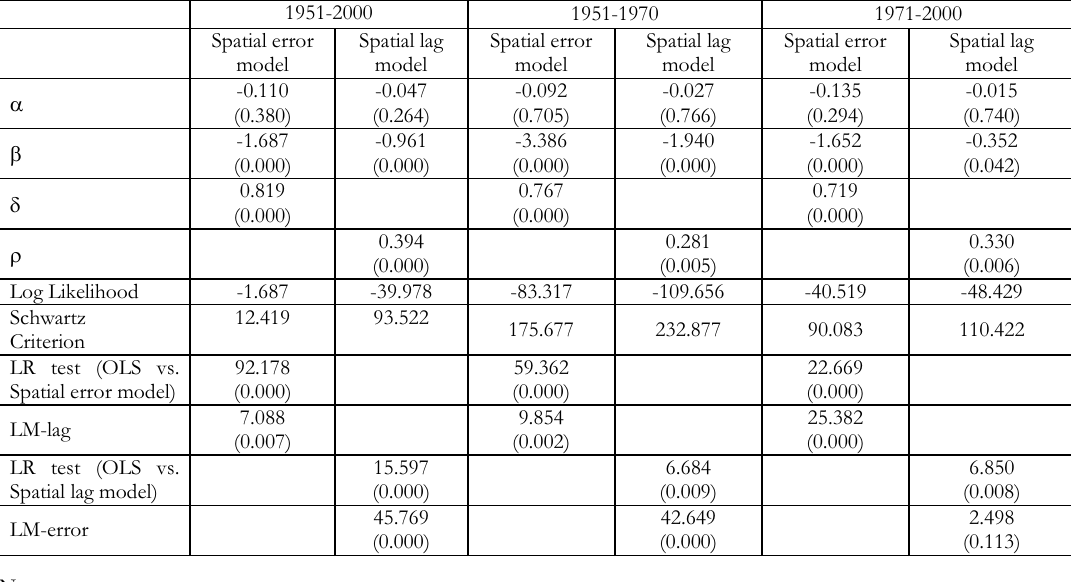
Per Capita Income Growth of Italian Provinces Spatial Dependence Models – ML Estimates (Number into brackets refer to the